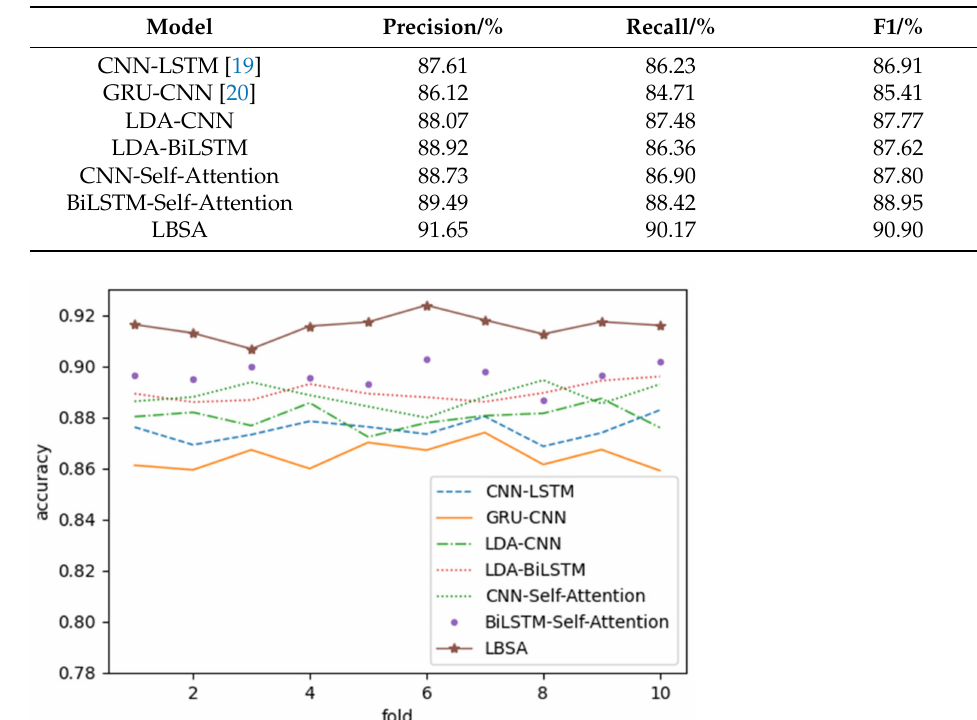
Table 5. Combined model comparison results.